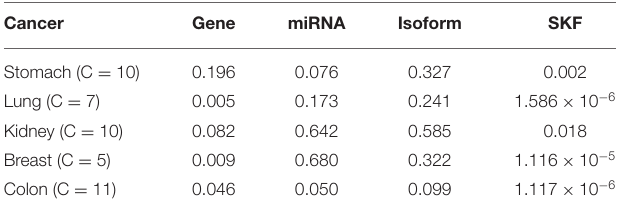
TABLE 2 | Comparison between SKF and the single kernel on Jiang Dataset. Cancer